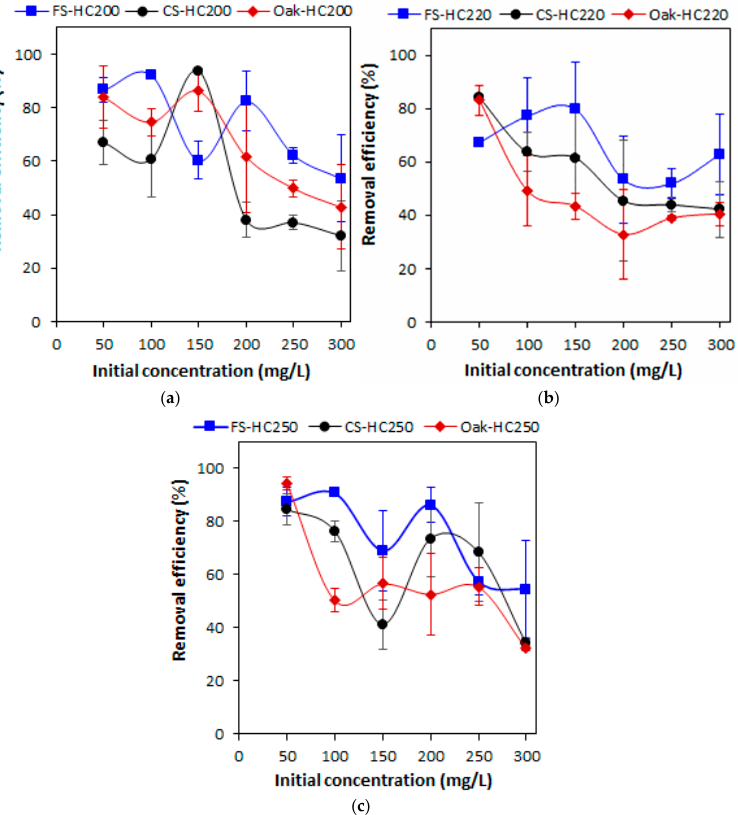
Figure 2. Effect of initial MB concentration and HTC temperature on adsorption removal efficiency of hydrochars derived at ( a ) 200 °C; ( b ) 220 °C; and ( c ) 250 °C. As shown in Figure 2a, at lower initial concentrations, the most effective hydrochar was Oak-HC250, removing 94.40% of the MB dye at 50 mg/L, which was followed by CS-HC200 and then FS-HC200, adsorbing 93.81% and 92.43% of the MB dye at 150 and 100 mg/L initial MB dye concentrations, respectively. The removal efficiency of CS-HC200 and Oak-HC200 reduced considerably when the initial MB dye concentration was increased beyond 150 mg/L, while FS-HC200 and Oak-250 showed a reduction in adsorption capacity after 200 and 50 mg/L respectively. The adsorbent best suited for the uptake of higher MB concentrations was FS-HC220, removing 62.89% (Figure 2b), which